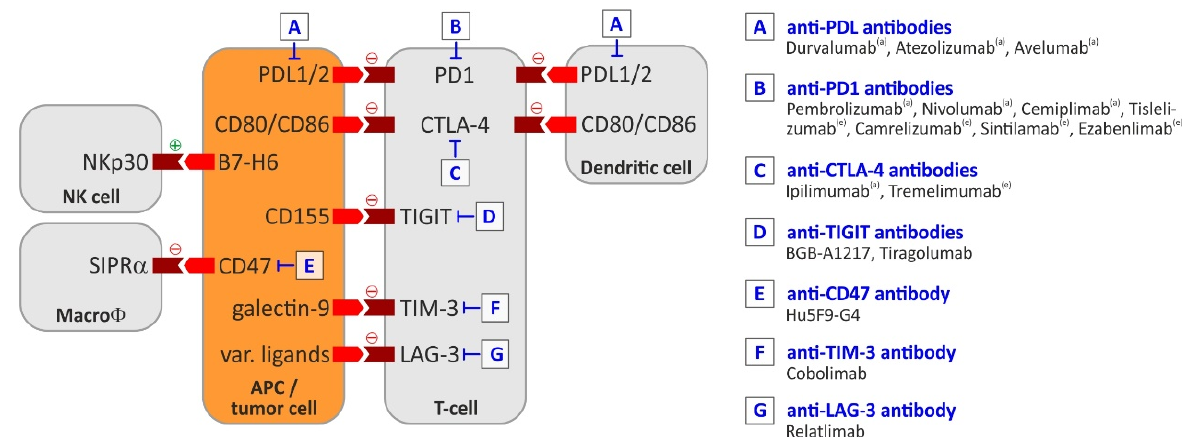
Figure 2. The most important immune checkpoints. Based on [16–22] . Abbreviations: APC, antigen-presenting cell; CTLA-4, cytotoxic T lymphocyte protein 4; LAG-3, lymphocyte activation gene 3 protein; PD1, programmed cell death protein 1; PDL1/2, programmed cell death protein ligand 1/2; TIGIT, T cell immunoreceptor with immunoglobulin and ITIM domains; TIM-3, T cell immunoglobulin and mucin-domain containing.